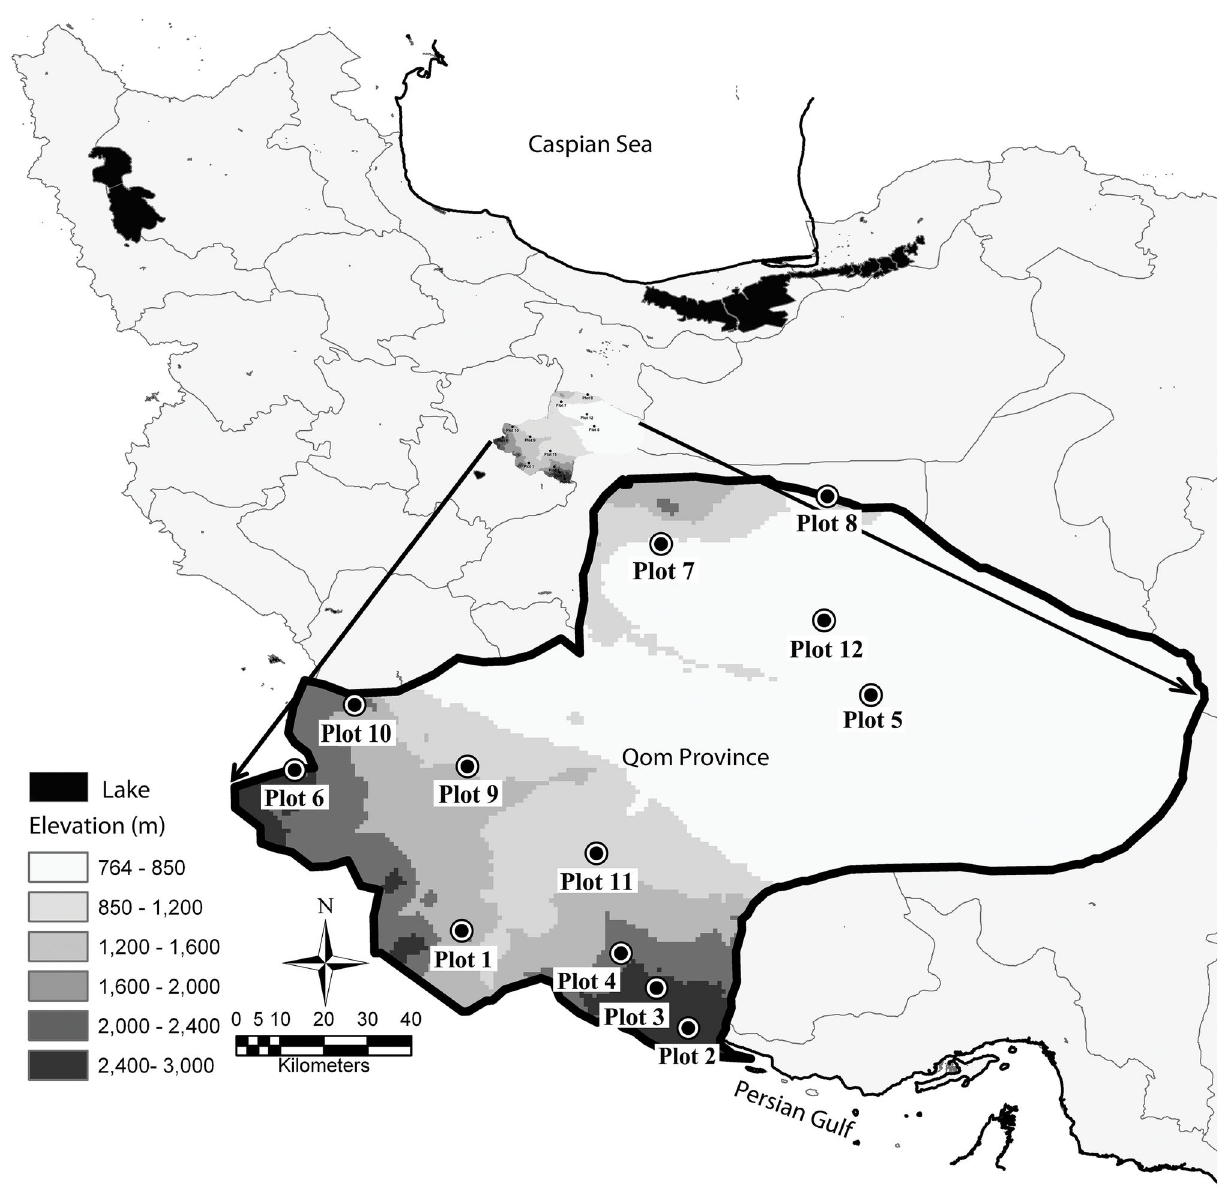
Figure 1. The plots distribution in the Qom Province of Iran. The plot numbers correspond to those in Table 1.